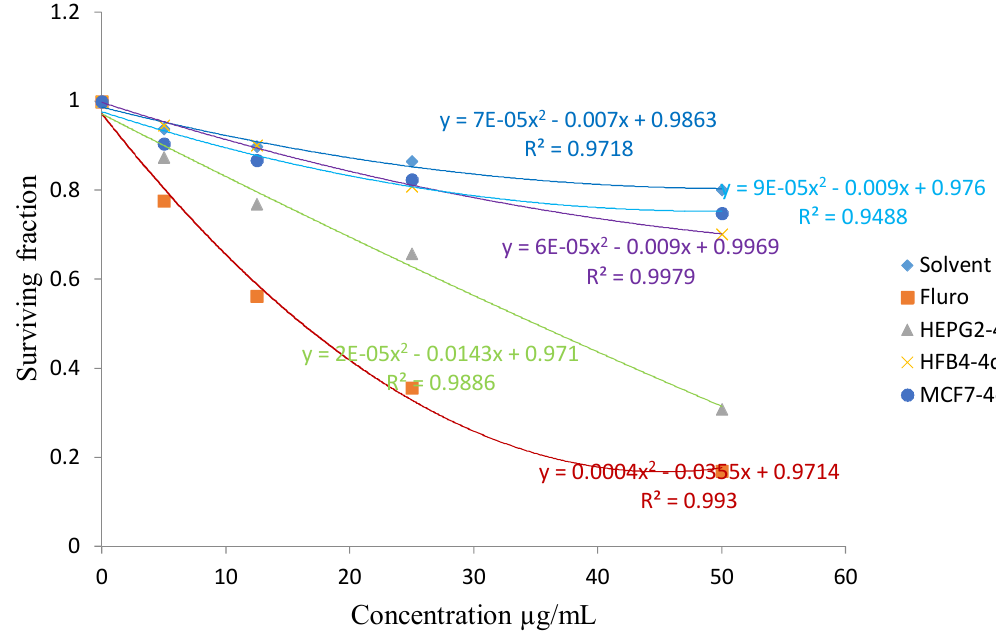
Figure 3. The cytotoxic activity of the synthesized product 4c against liver HEPG2 cancer cell line.